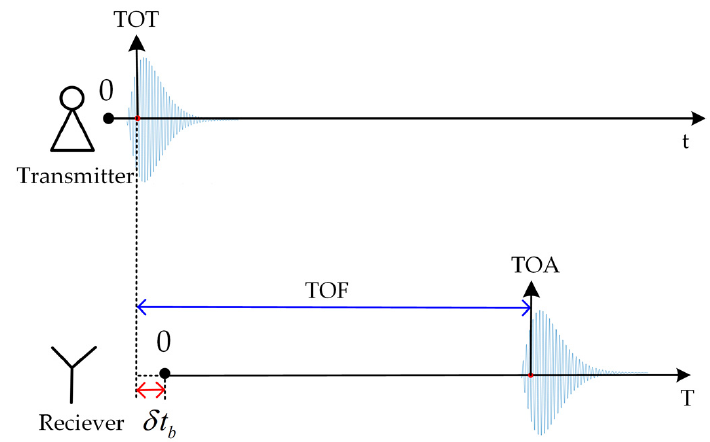
Figure 1. Schematic of eLoran pseudorange measurement principle.